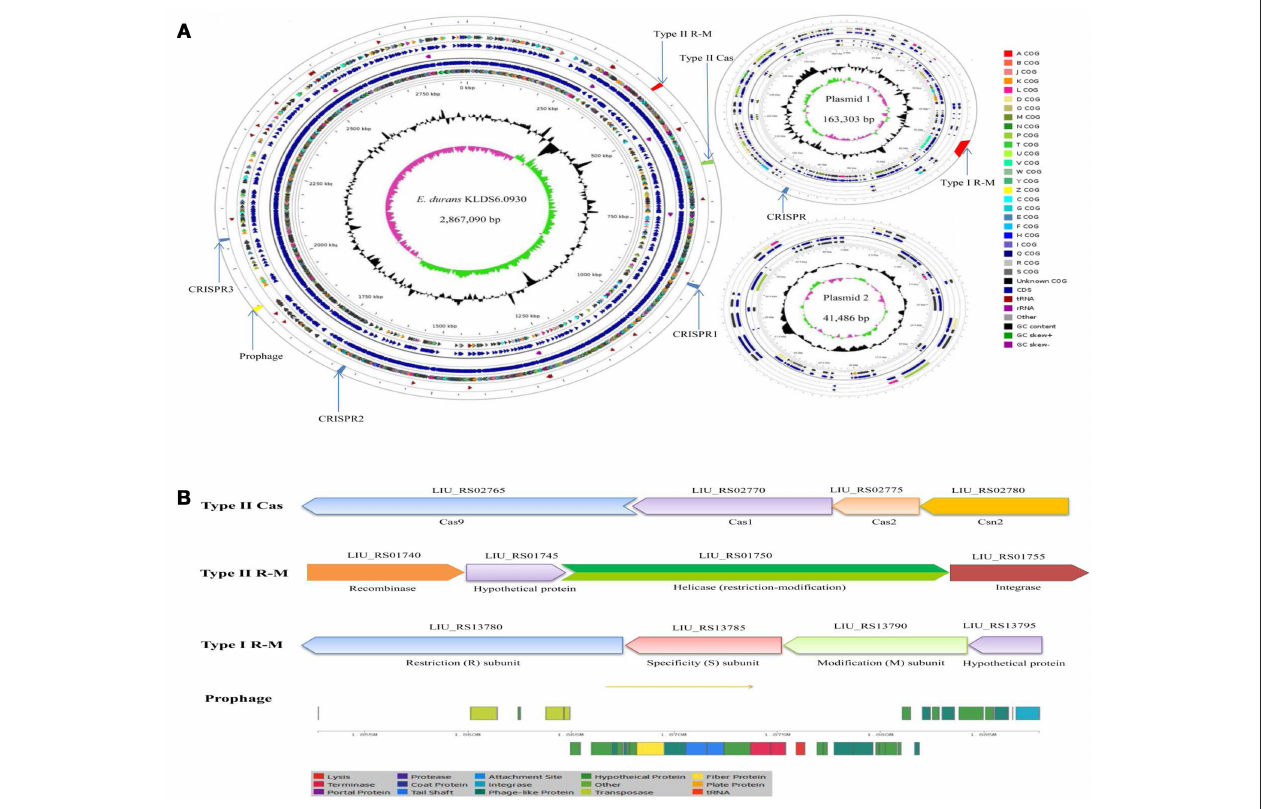
FIGURE 2 | Circular genome map and defense systems of Enterococcus durans KLDS6.0930. (A) Circular genome map. From periphery to center: Defense system and prophage, tRNA, Protein coding genes (CDSs) on forward strand colored according to the assigned COG classes, Genes on forward strand, rRNA, Genes on reverse strand, CDSs on reverse strand colored according to the assigned COG classes, Genome position in kbp, GC content; GC skew (G-C)/(G + C); (B) Organizations of the Type II cas, Type II R-M, Type I R-M, and prophage